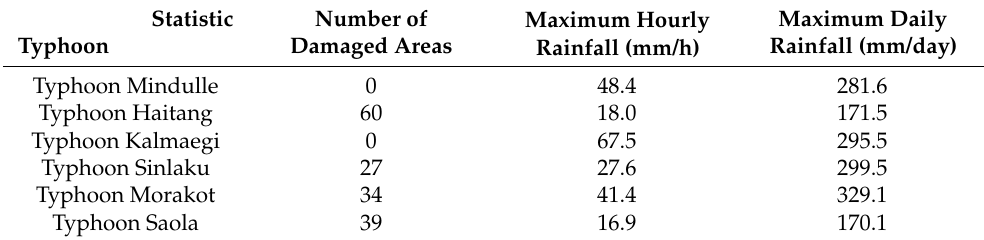
Table 23. Number of damaged areas and maximum hourly and daily rainfall, by typhoon